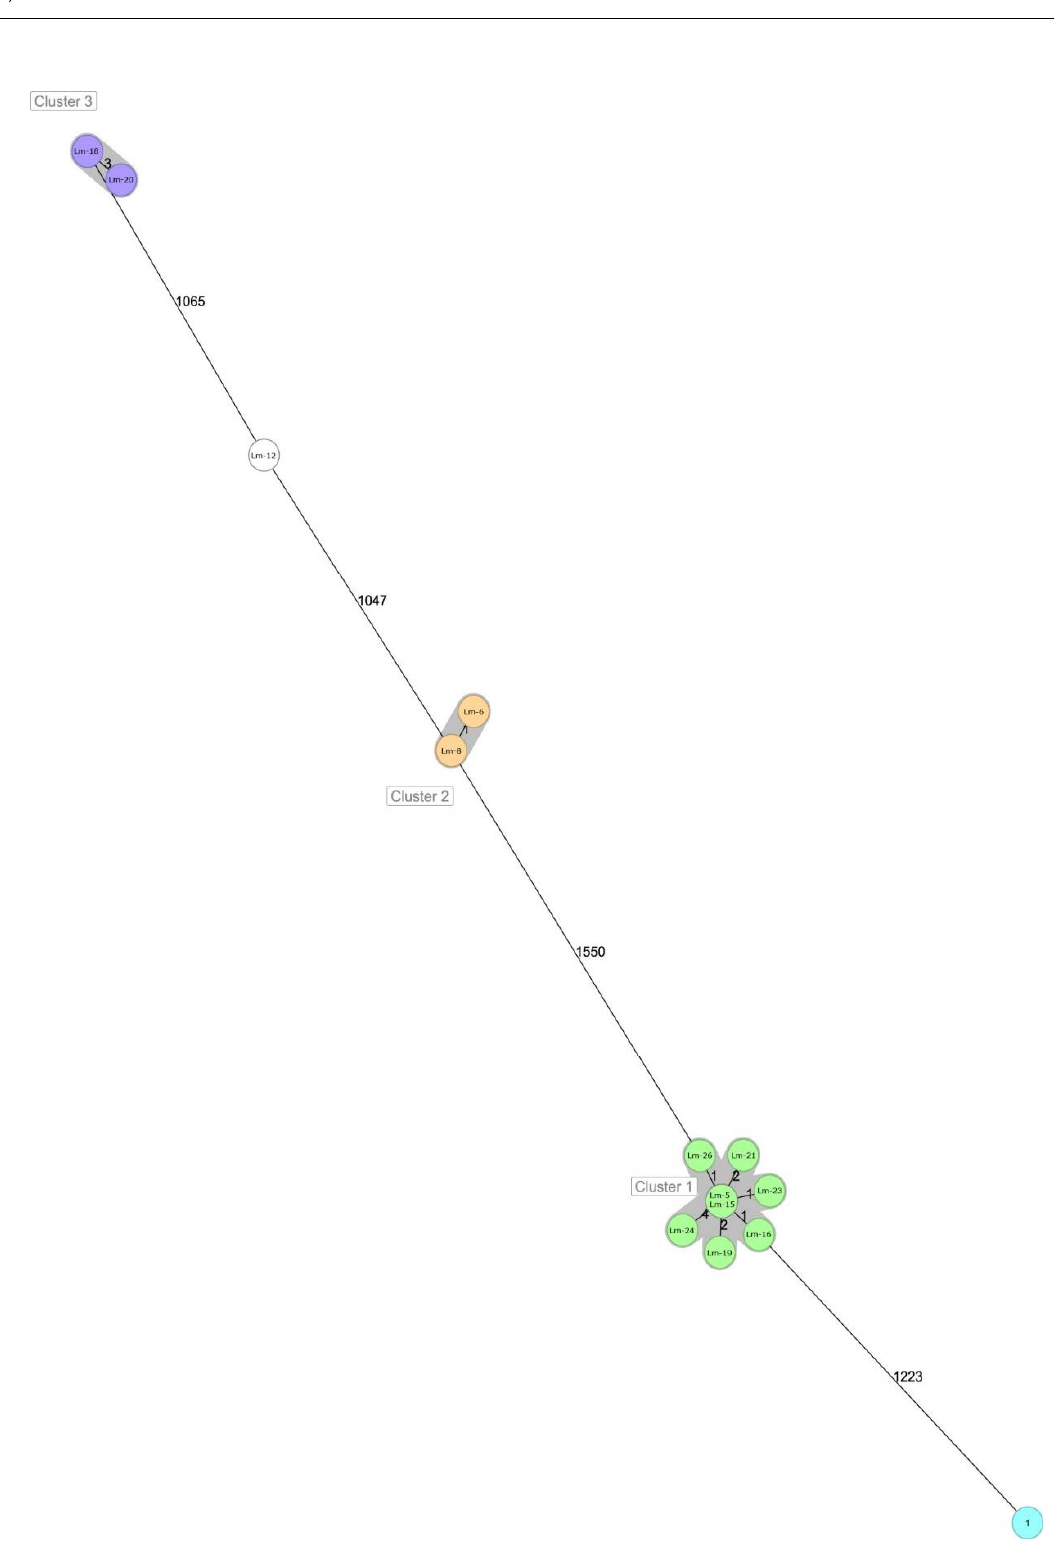
Figure 3. Minimum spanning tree (MST) showing the relatedness of the 14 isolates of L. monocytogenes strains isolated from the final product (FP),FCS and n-FCS of the frozen vegetable plant. MLST profiles are represented by circles and the colours correspond to different clusters. The length of the lines connecting MLST profiles is proportional to the number of allelic differences between circles. A grey zone surrounds the group of circles that share the same cgMLST type (STs).